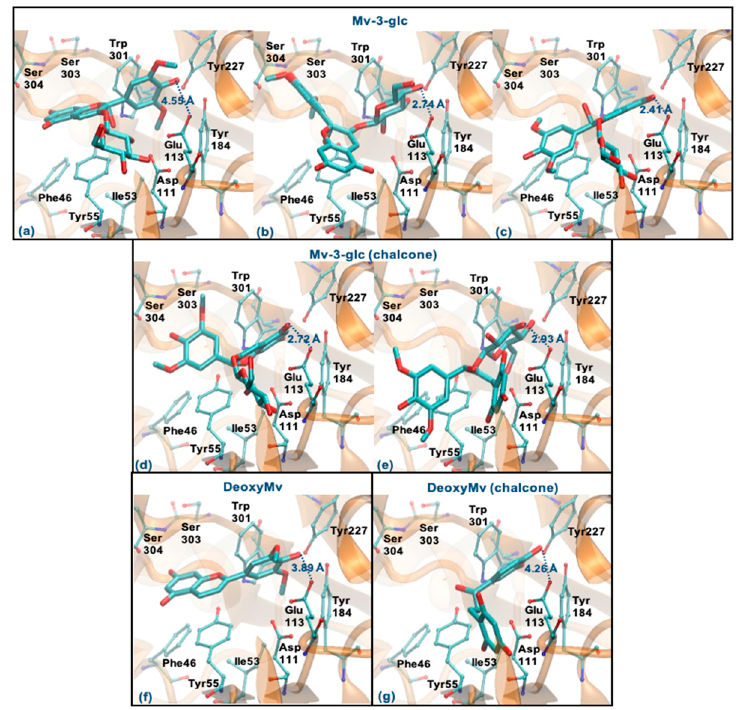
Figure 9. Representation of the structure of hyaluronidase complexed with Mv-3-glc—pseudobase carbinol (interaction by ring B—( a ), interaction by glucose—( b ), interaction by rings A and C—( c )) and chalcone (interaction by rings A and C—( d ), interaction by glucose—( e ))—and DeoxyMv– pseudobase carbinol (interaction by ring B—( f )) and chalcone (interaction by ring B—( g ))—showing the interacting residues of the active site. The enzyme is depicted in cartoon and colored in orange, the ligands are represented with sticks and colored by atom type, whilst the interacting residues are depicted in ball-and-sticks and colored by atom type. Hydrogen atoms are not represented to simplify the visualization.